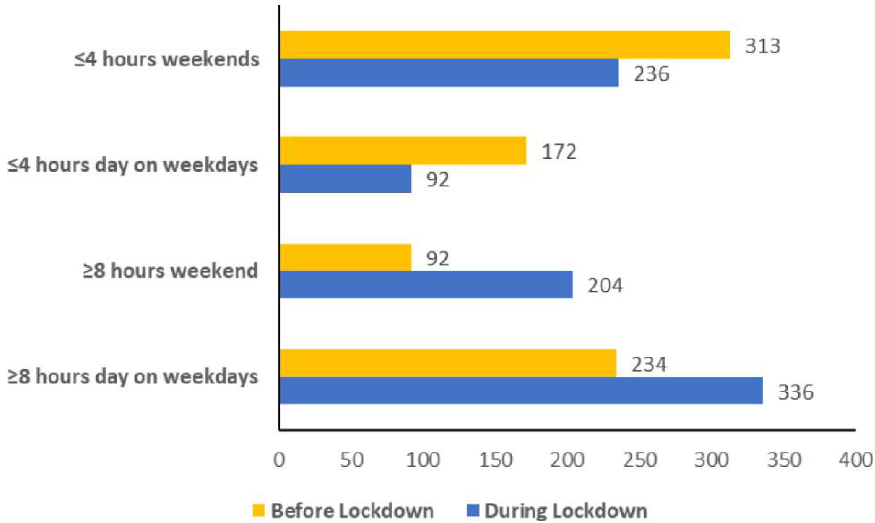
Figure 2. Number of participants sitting for ≤4 and ≥8 h per day on weekdays and weekends before and during lockdown. and during